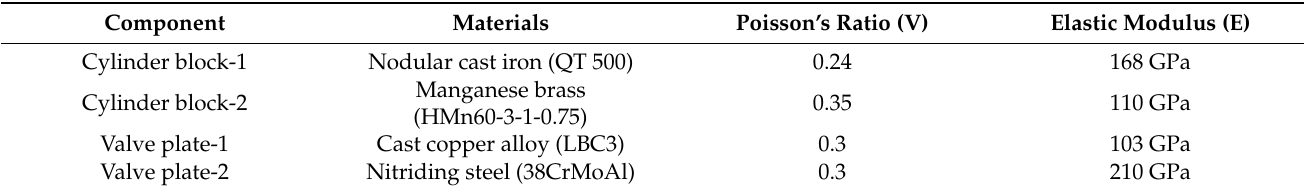
Table 2. Mechanical Properties of Valve Plate/Cylinder Block Materials.